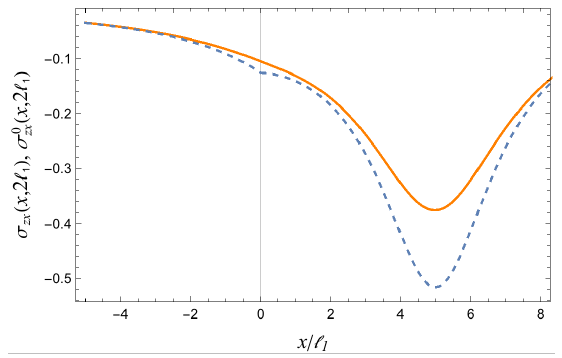
Figure 2: The profile of σ zx ( x , y = 2) when µ 2 / µ 1 = 10 and l 2 / l 1 = 2 with the dislocation being placed at x curves correspond to the gradient and classical solutions, respec- tively. The stress values are given in units of µ